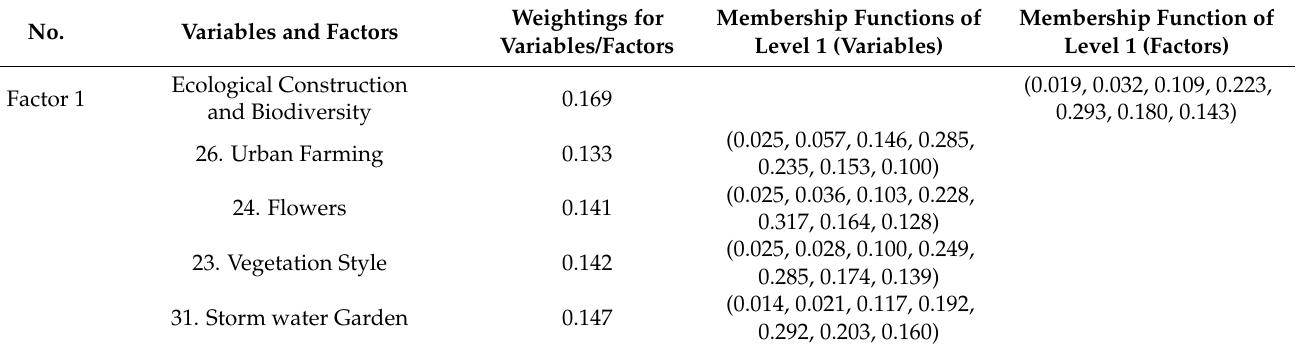
Table A1. Weightings and membership functions of all variables and